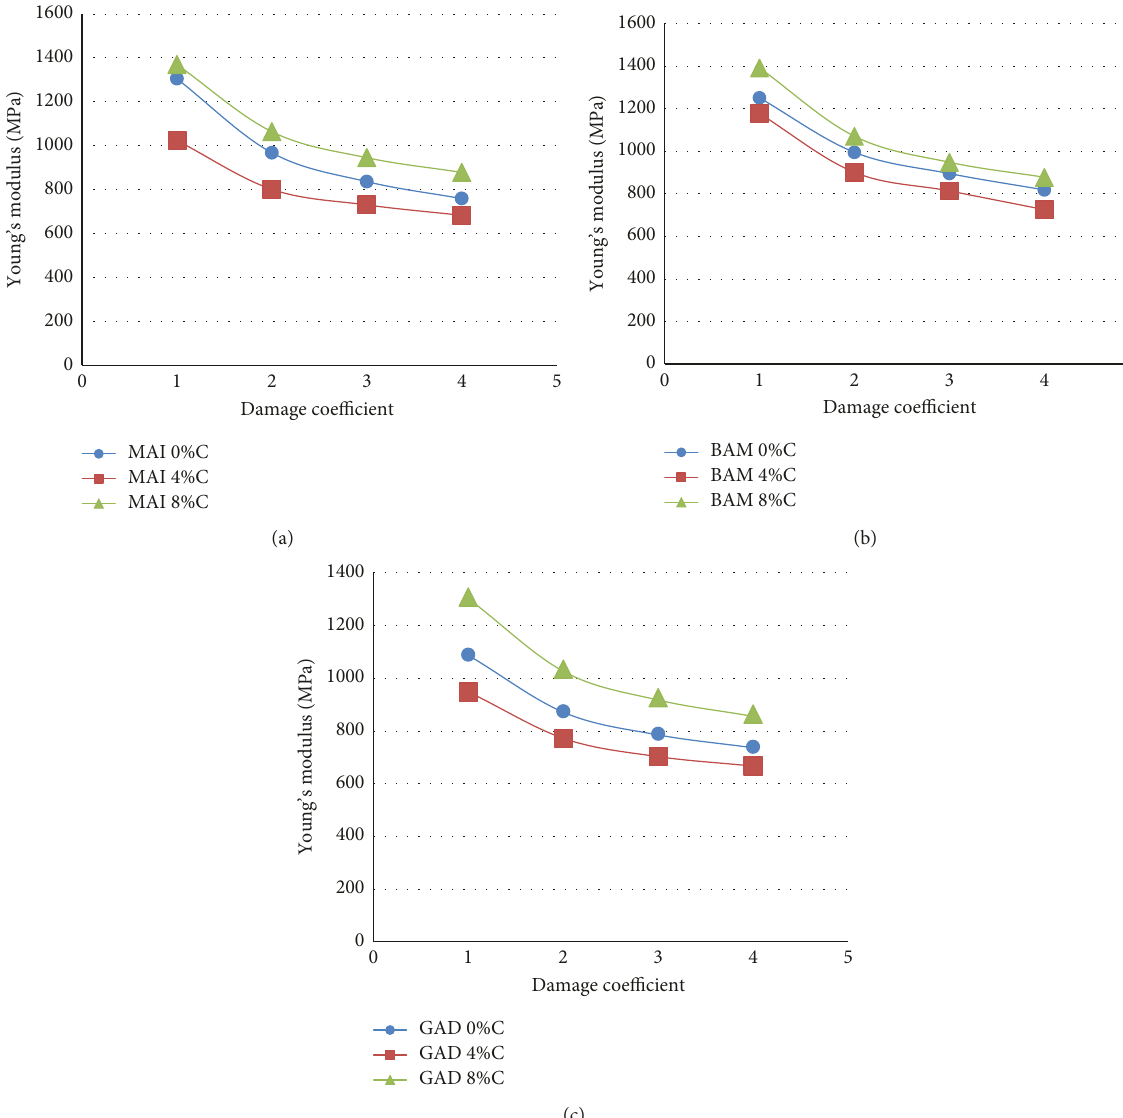
Figure 10: Young’s modulus compared to the damage coefficient of CEBs and